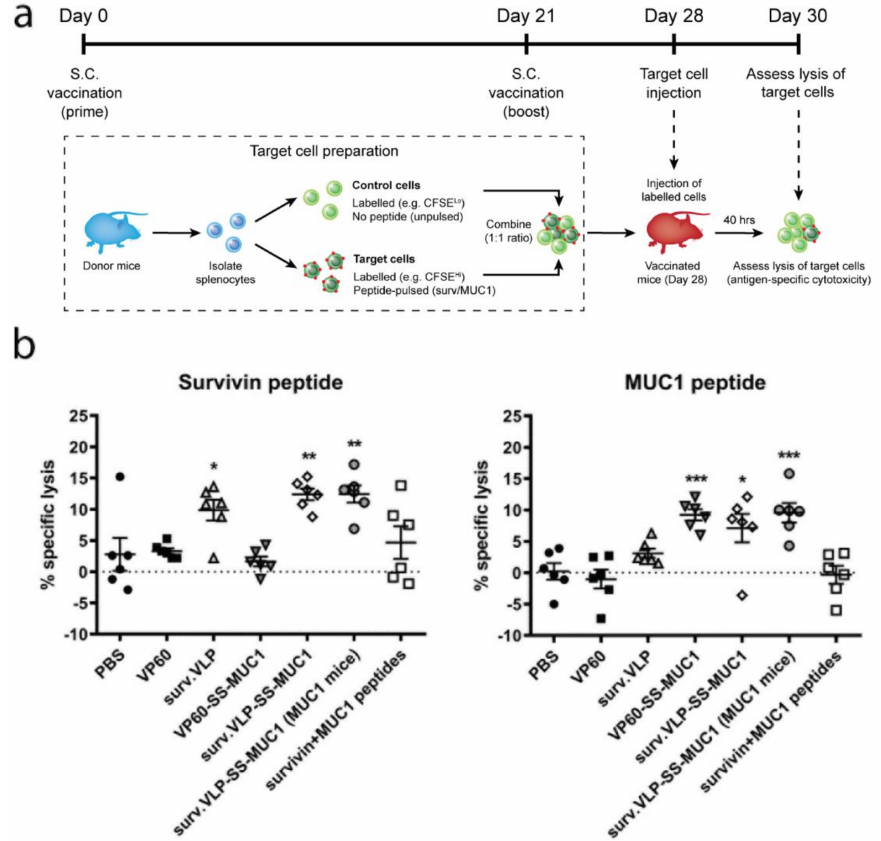
Figure 2. In vivo cytotoxicity induced by surv.VLP-SS-MUC1. ( a ) Timeline of cytotoxicity assay. On day 0, mice ( n = 6 per treatment group) were vaccinated with VLPs delivering one or two antigens or empty VLP controls (VP60). 21 days later, mice received a boost with the same treatment and, on day 28, mice were injected with target cells, pulsed with either survivin or MUC1 peptide. Mice were culled 48 h after target cell injection, and splenocytes were analysed. ( b ) Specific lysis of target cells was calculated by comparing unpulsed to target cell ratio. Results show percent specific lysis of vaccinated treatment groups compared to the VP60 group ± SEM. Statistical significance was determined by one-way ANOVA with Tukey’s post hoc test, *** p < 0.001, ** p < 0.01, * p <